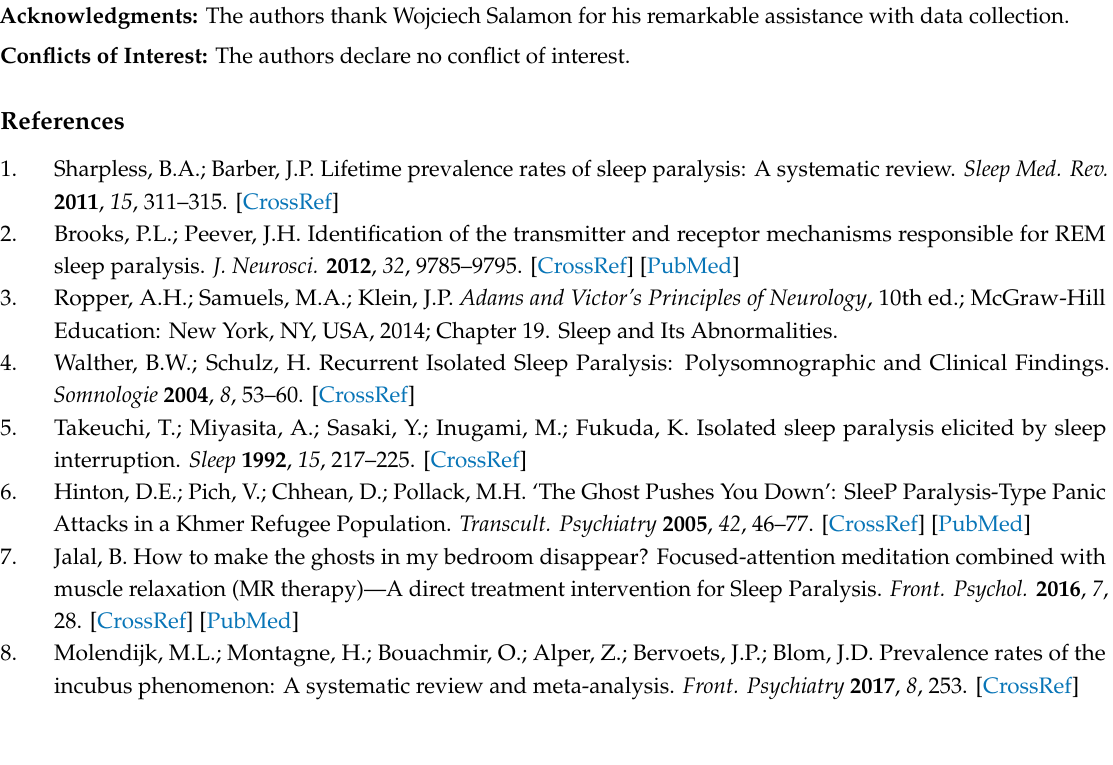
Table S1: Correlation between lifestyle related SP risk factors and the number of SP